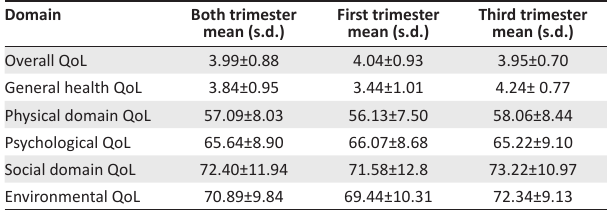
TABLE 3: Quality of life scores.